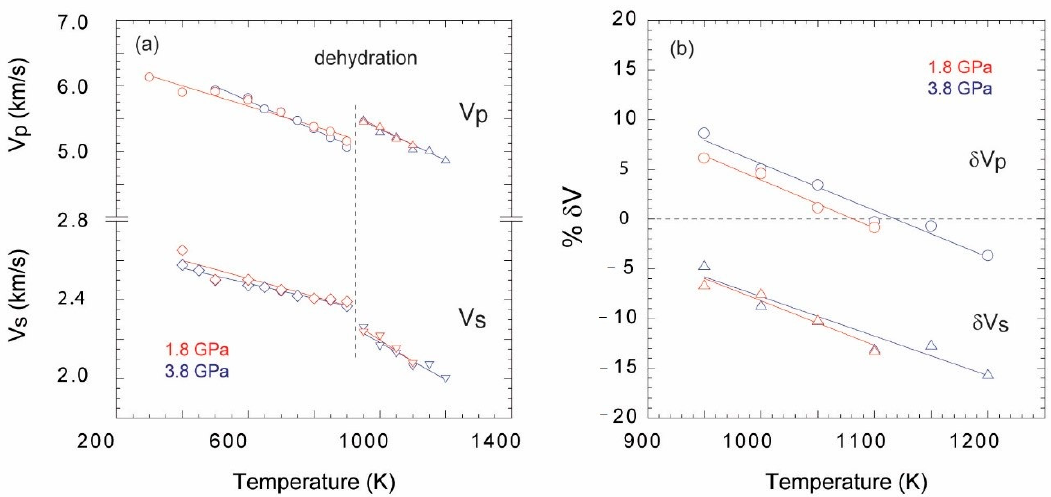
Figure 2. ( a ) Primary (Vp) and secondary (Vs) wave velocities as a function of temperature at 1.8 and 3.8 GPa. ( b ) The% drop in velocity ( δ Vp, δ Vs) upon dehydration at 1.8 and 3.8 GPa compared to chlorite before dehydration. The lines are the linear fits through data points. Uncertainties in velocity estimations are estimated to be less than 2.0% (2 σ ), smaller than the symbol size.